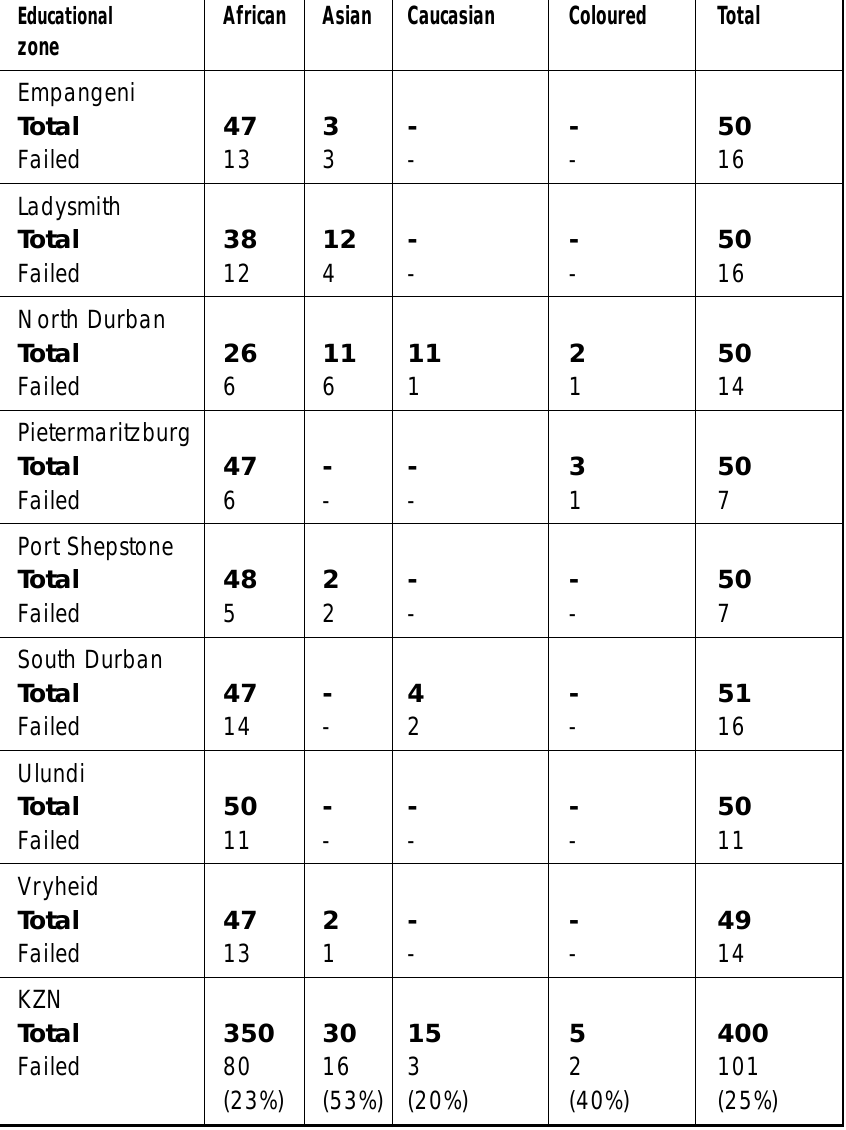
Table 3: The racial distribution of children presenting as BCH in specific regions of KwaZulu